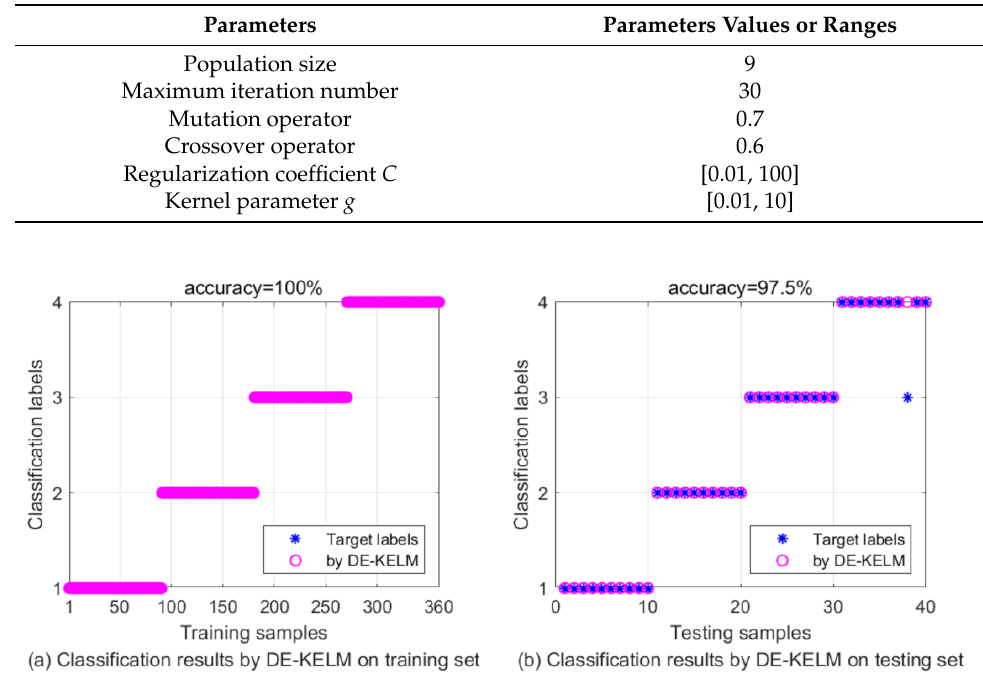
Figure 15. Fault classification results by DE-KELM on the training and testing